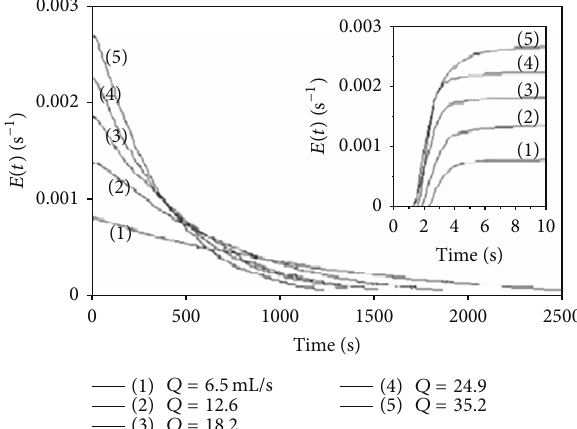
Figure 12: Effects of flow rate with RTD